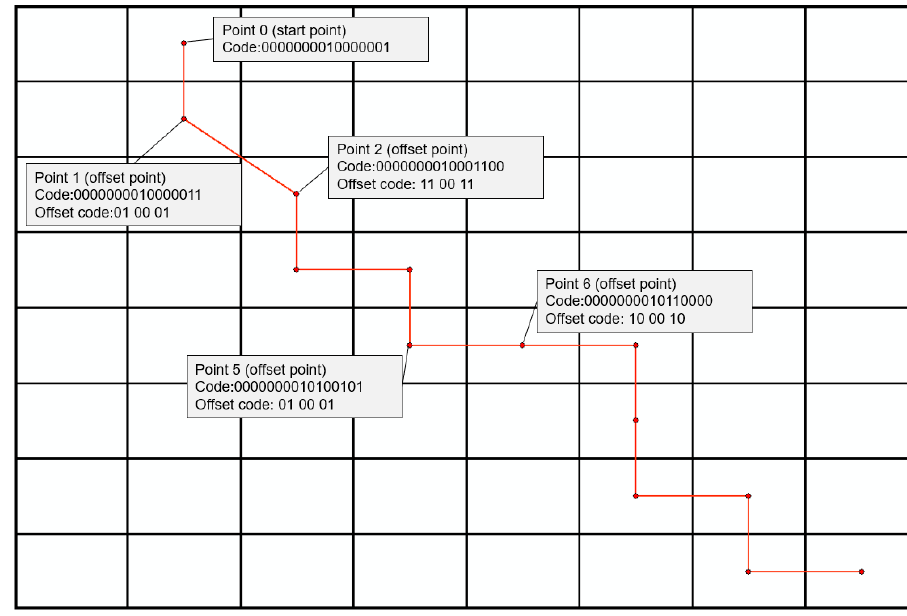
Figure 5. Corresponding figure showing line or polygon features offset storage.